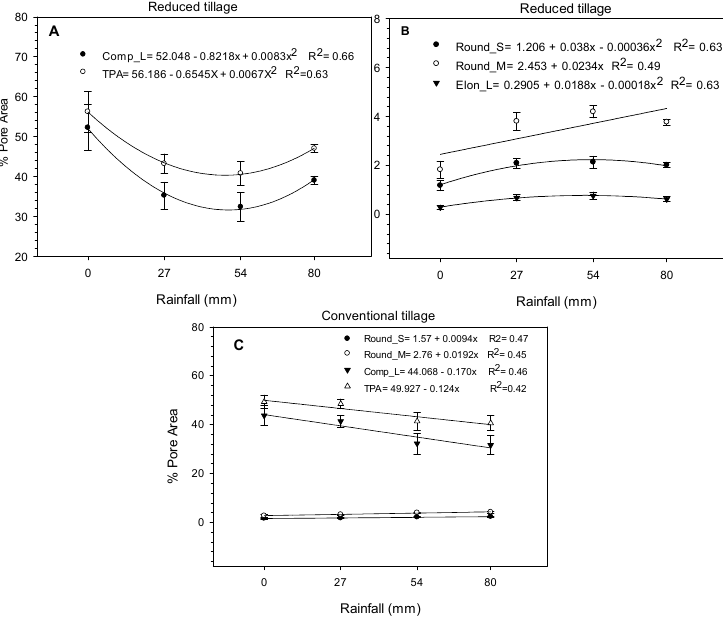
Figure 2. Effect of applied rainfall on percentage of pore area, for layer 1 in 2010 year, in reduced ( A , B ) and conventional tillage ( C ). Round_S: rounded small; Round_M: rounded medium; Elong_L: elongated large; Comp_L: complex large; TPA: total pore area. Error bars are standard